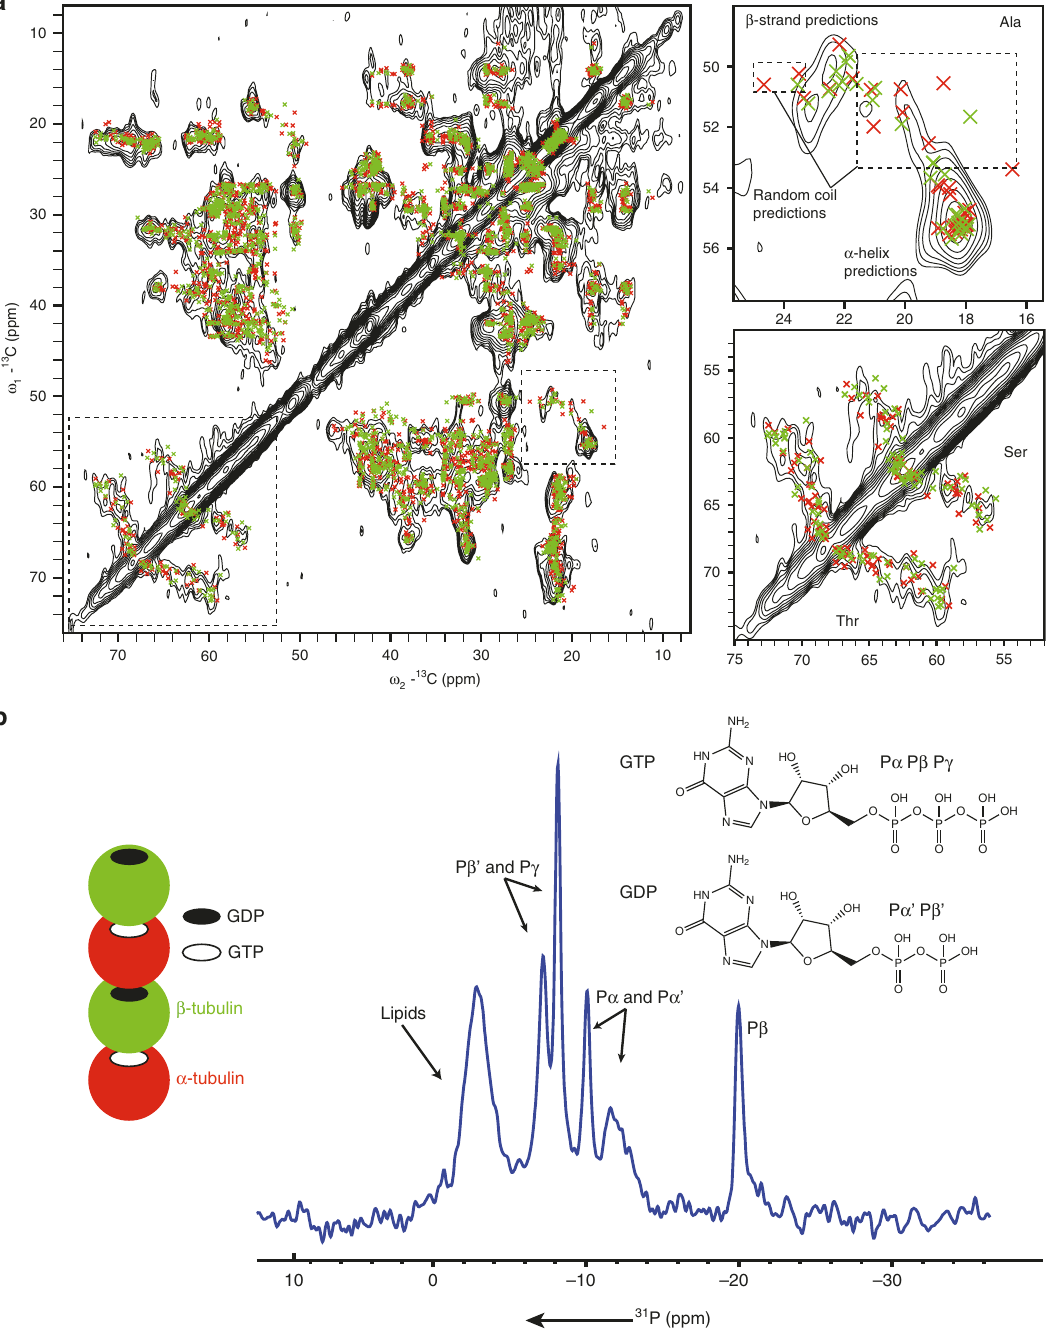
Fig. 2 SsNMR spectra of [ 13 C, 15 N]-labeled MTs. a The 2D 13 C – 13 C radio frequency-driven recoupling (RFDR) experiment was performed at 270 K set temperature with a MAS rate of 44 kHz with zoom in ’ s on serine, threonine and alanine C α – C β regions. Crosses indicate the chemical shift predictions for MTs from SHIFTX2 57 and FANDAS 2.0 30 based on the EM structure (PDB 5SYF). Red and green crosses represent predictions for α -tubulin and β -tubulin, respectively. b Schematic representation of the GTP/GDP binding to tubulin in MTs (left), and 1D H – 31 P CP experiment at ambient temperature with MAS rate of 11 kHz allows to observe GTP and GDP bound to